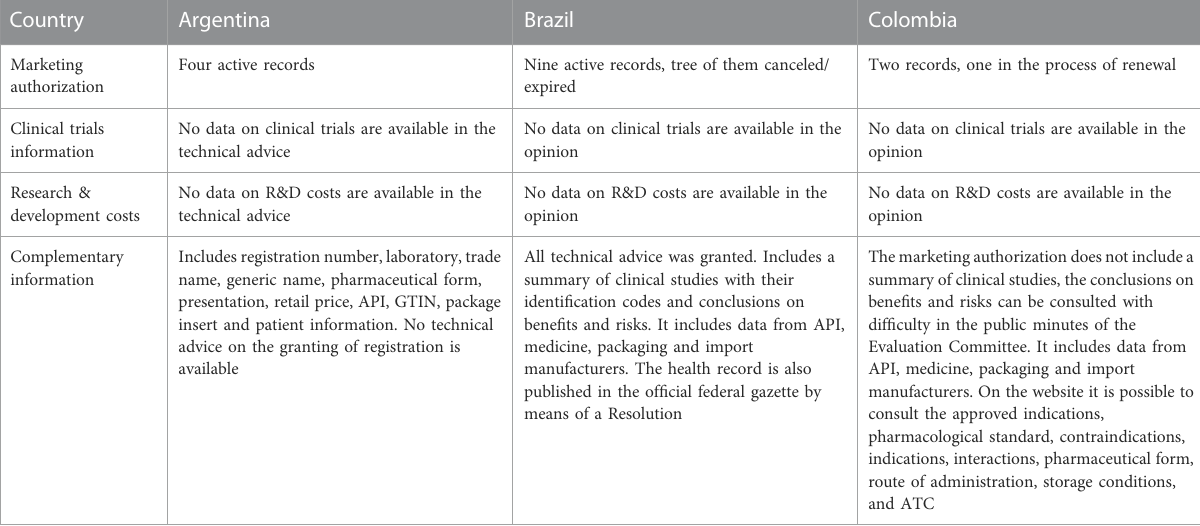
TABLE 1 Marketing authorization for in fl iximab in Argentina, Brazil and Colombia.